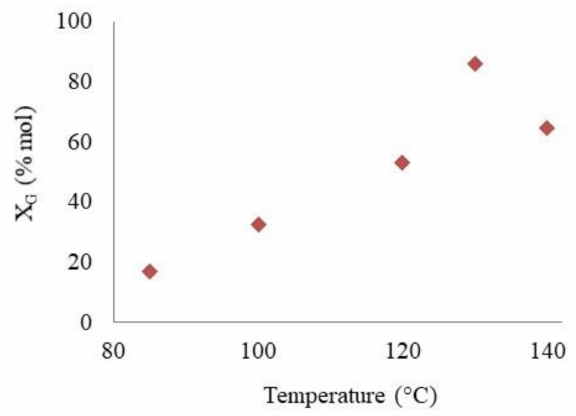
Figure 5. Influence of reaction temperature on glycerol conversion over catalyst 1 . Reaction conditions: TBA / G molar ratio = 4; catalyst 1 amount 5 wt.%; t = 15 min.